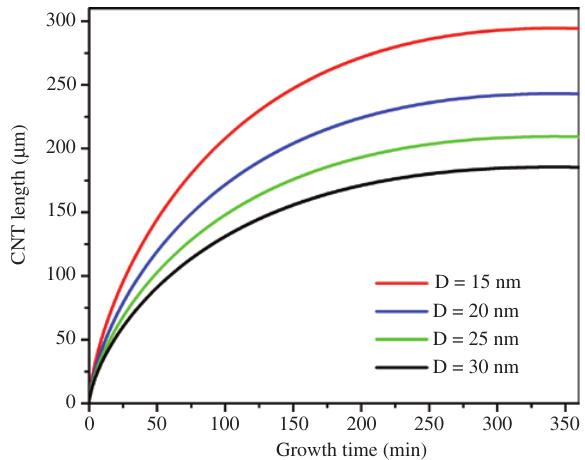
Figure 4: Growth of CNTs with different diameters on GS.